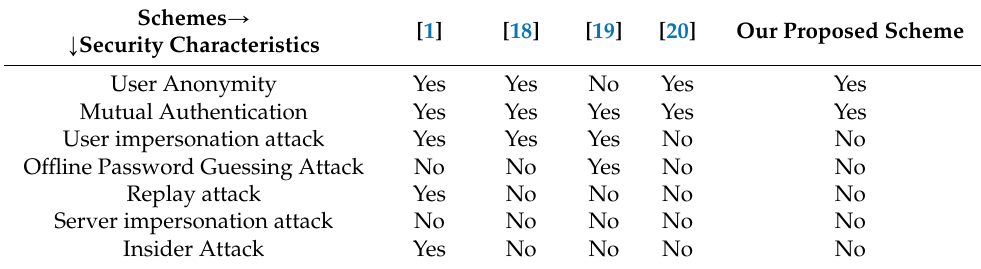
Table 3. Comparisons of our scheme with others based on various security parameters. Schemes Ñ